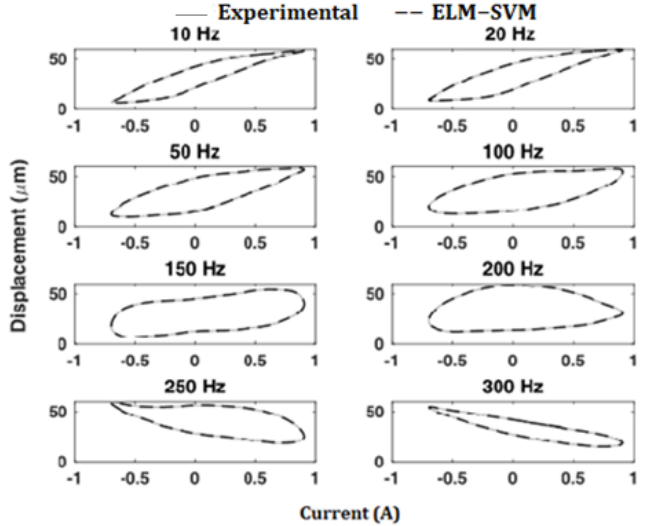
Figure 14. Comparisons of the hysteresis loops between the results obtained by the ELM − SVM under sinusoidal excitations at various frequencies and the experimental results [33] for the magnetostrictive actuator.